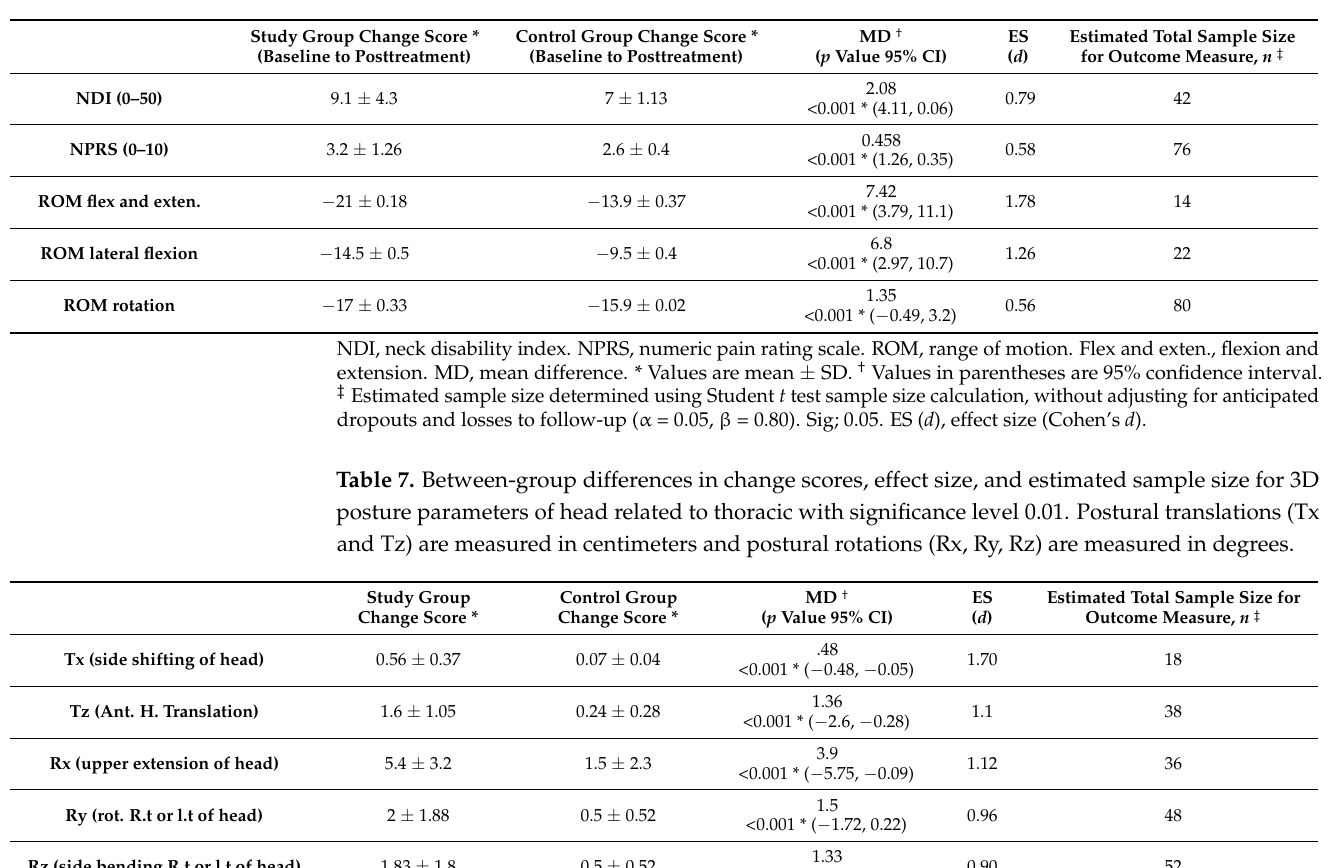
Table 6. Between-group differences in change scores, effect size, and estimated sample size for each of the secondary outcome measures with significance level of 0.05. The mean difference (MD) is the difference between the two groups’ change score values. A negative value for the change (MD) in range of motion indicates an increase in the overall motion for the variable for that group whereas the difference between the group is a positive number indicating greater improvement for the study group. Ranges of motion (ROM) are measured in degrees.